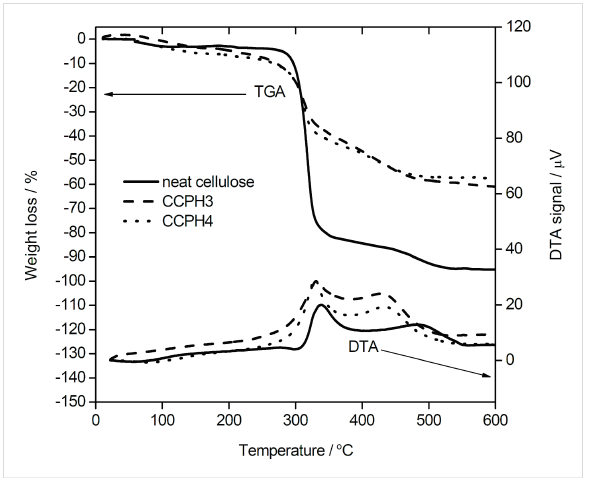
Figure 10: Representative TGA and DTA data of select samples. For full data see Table 3.